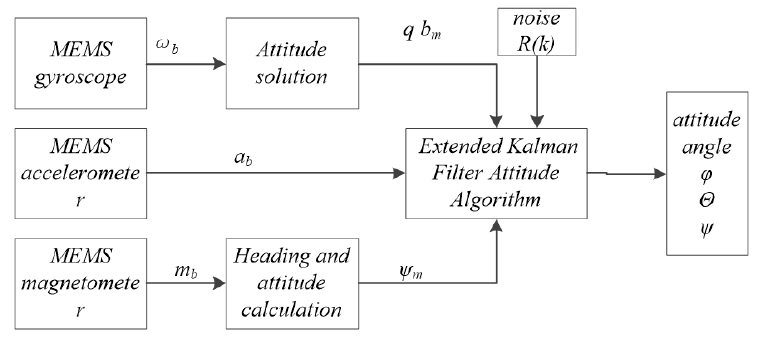
Figure 2. EKF algorithm structure diagram.